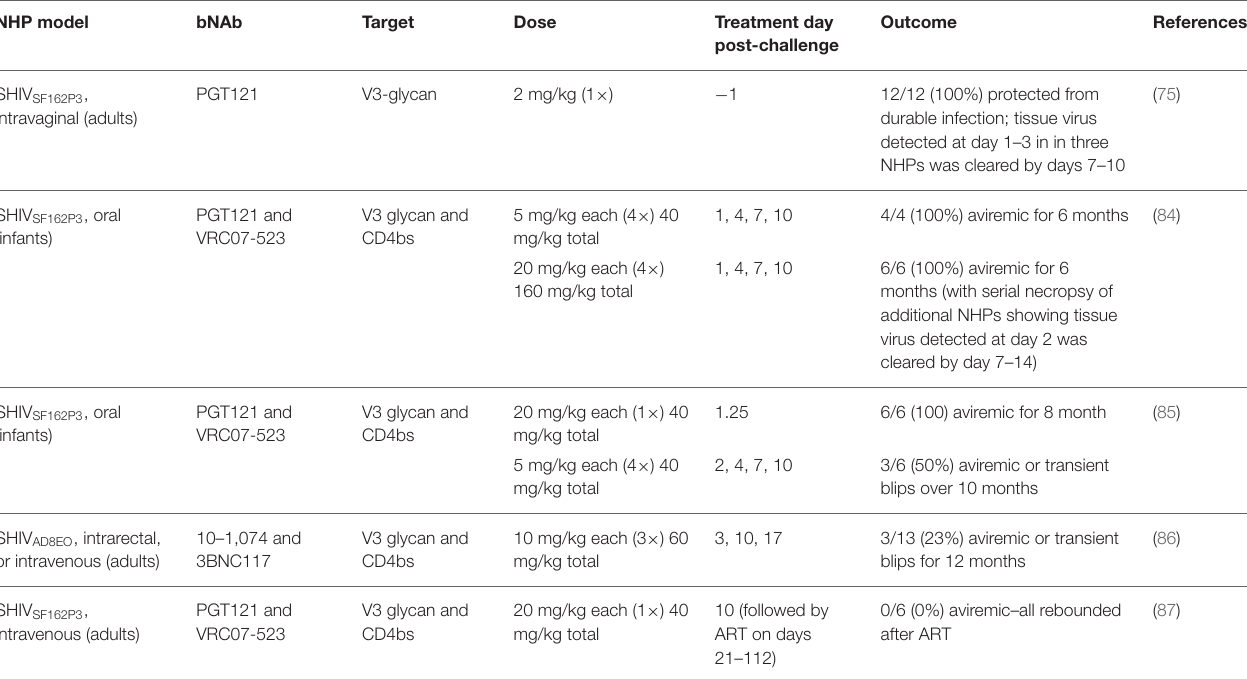
TABLE 1 | Protective efficacy of bNAbs delivered as PEP in infant and adult macaques. NHP